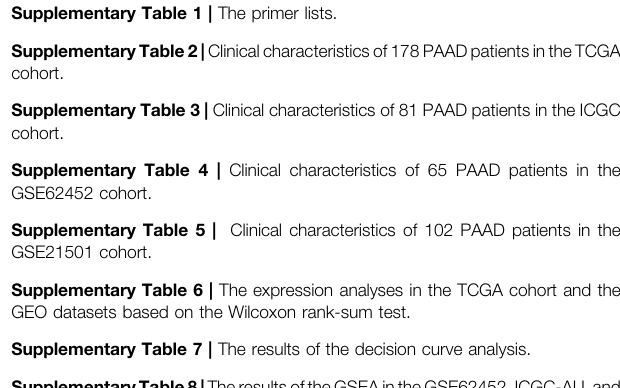
Supplementary Table 7 | The results of the decision curve